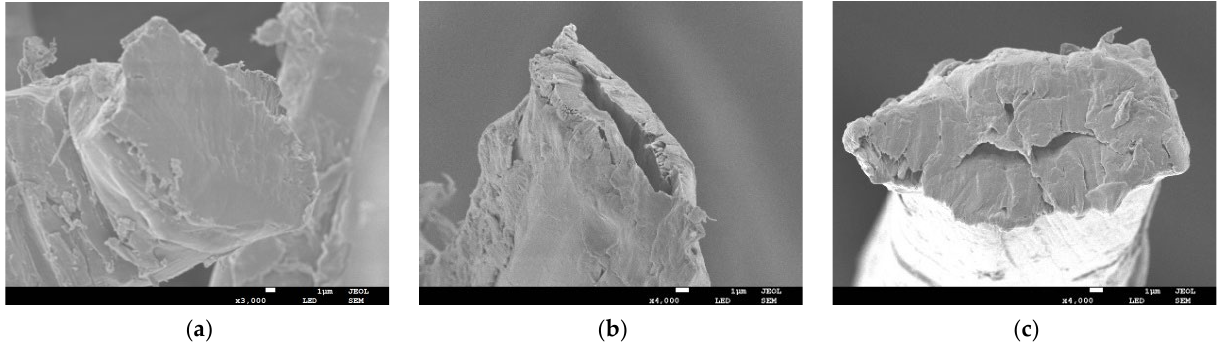
Figure 7. Scanning electron microscope photos of transverse morphology of waste hemp fiber: ( a ) head-end morphology of waste hemp fibers (×3000); ( b ) cavity structure of the flattened ribbon-like part of waste hemp fibers (×4000); ( c ) cavity structure of the tubular part of waste hemp fibers (×4000).